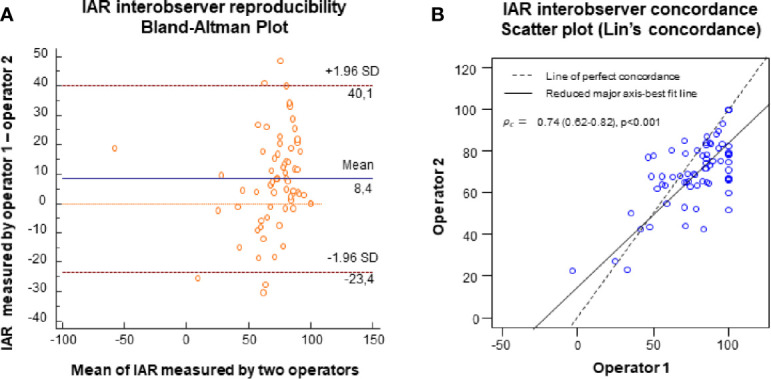

(A) Bland-Altman plot showing interobserver agreement of IAR measurements on B-mode US images. The x-axe shows the mean of IAR measurements, the y-axe shows the difference between the measurements. Orange line = 0; blue line = mean difference between operators, red lines = ± 95% ( ± 1.96 SD) limits of agreement. (B) Scatter plot of the Lin’s concordance (interobserver concordance) coefficient, showing how far the fitted relationship between x and y deviates from the 45° concordance line through the origin. The graph shows good precision (ρ=0.80), almost no systematic bias (C
b), and a substantial interobserver concordance (ρ
c=0.74).